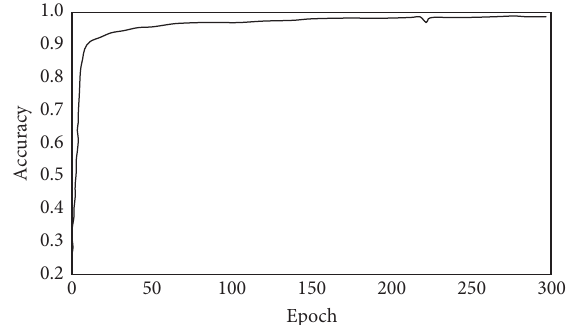
Figure 5: Accuracy of the validation set.